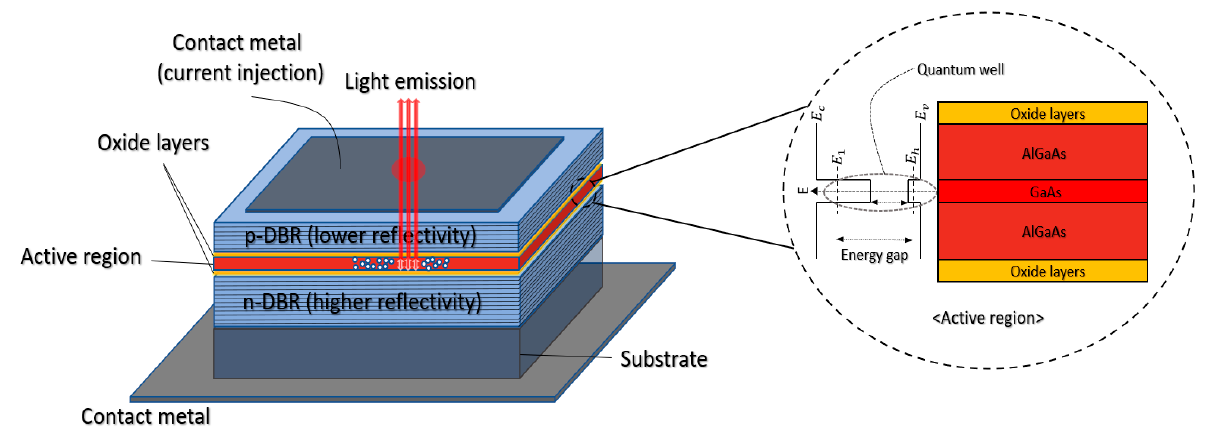
Figure 1. The basic structure of AlGaAs/GaAs VCSEL ( left ). The active region ( right ). For the infrared VCSELs, DBR pairs of InP/AlGaInAs (850 to 980 nm) or AlGaAs/Al- GaAs (1300 nm to 1550 nm) are used [20]. In [29], it was shown that the wave between 650